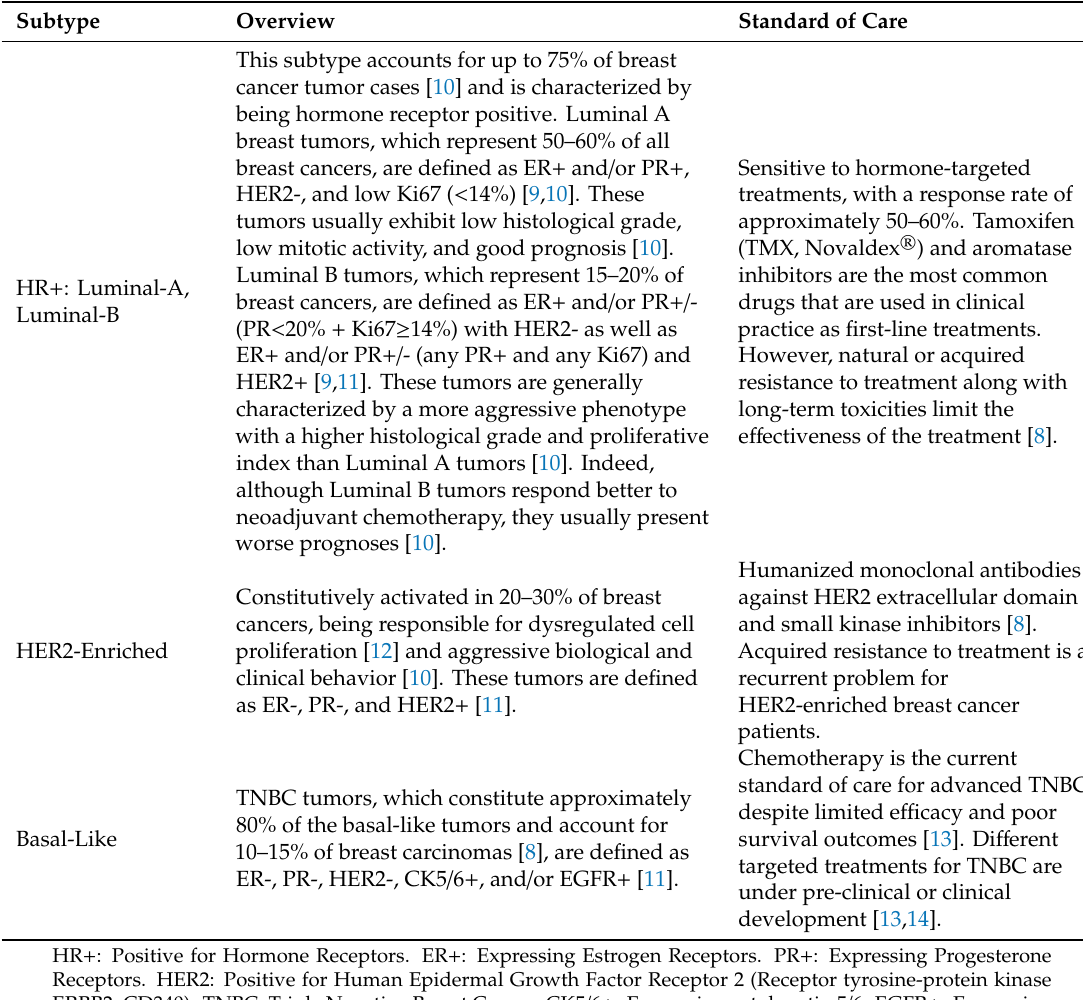
Table 1. Breast cancer classification and standard of